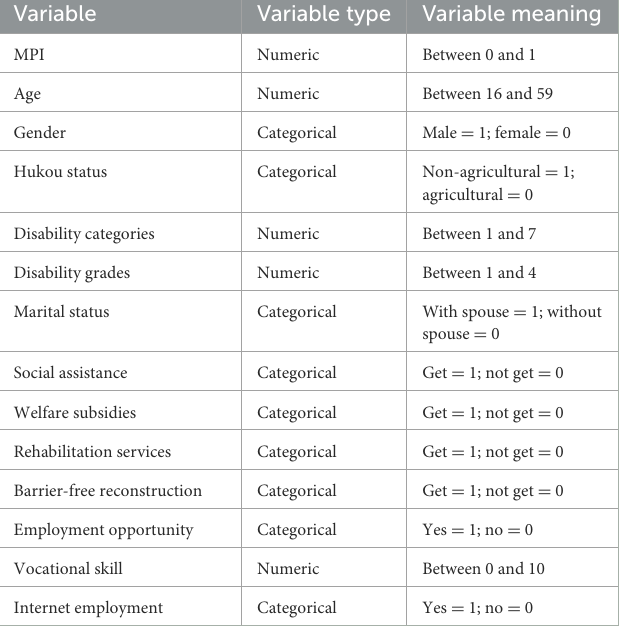
TABLE 5 Definition of